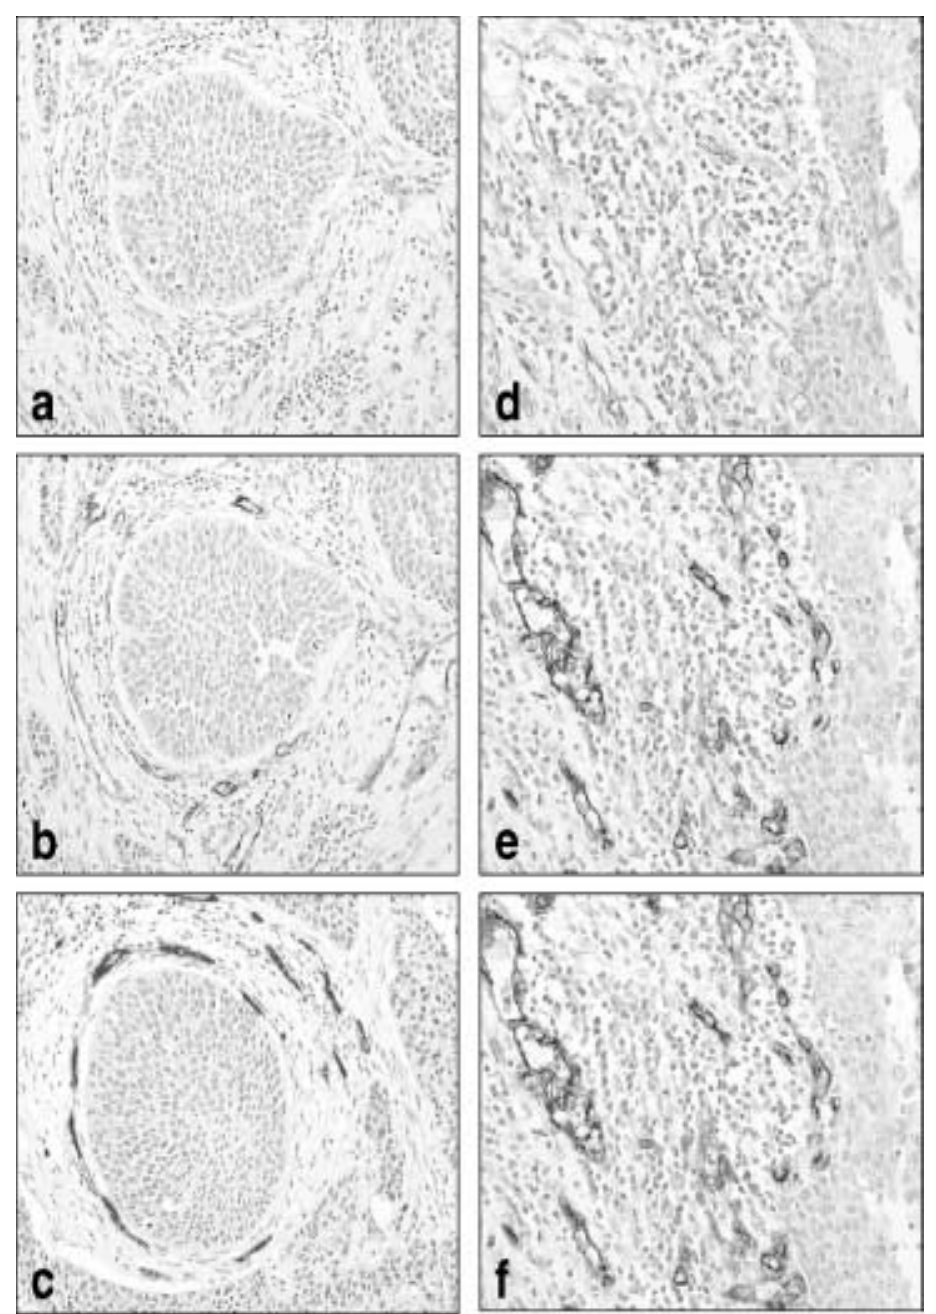
Fig. 1. Immunohistochemical staining results for the standard procedure and in combination with CARD amplification. An immunohistochemi- cally stained tisue section of tongue carcinoma, with very weakly stained and even unstained vessels using the standard procedure with DAB (a) and the successive, serial section using CARD amplification, disclosing more vessel profiles and more intensely stained vessels with DAB (b). A non-successive, serial section of the same area in the same tumour, with vessels visualised with Vector Red after CARD amplification also showed intensely stained vessels, however Vector Red gave more blurred vessel contours than DAB (c). Another SCC with stained vessels using the standard procedure with DAB (d) and the successive, serial section using CARD amplification exhibiting more intensely stained vessels, no background staining, and plasma cells of the inflammatory infiltrate remained unstained (e). The same image as (e), with vessel profiles found after automated recognition by the image analysis system are marked with green contours (f). This figure can be viewed on http://www.esacp.